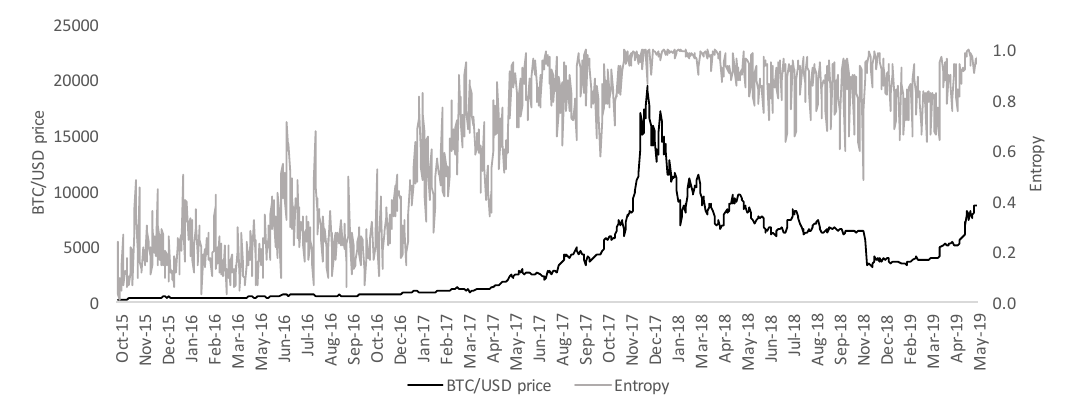
Figure 1. Bitcoin’s daily closing prices and